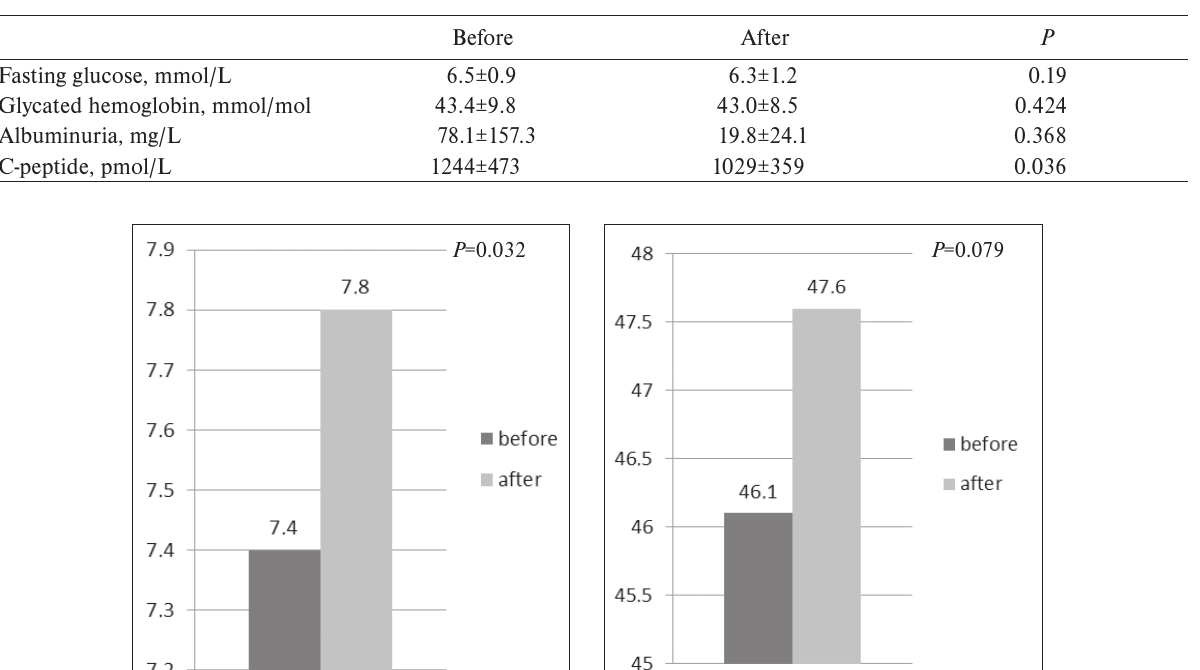
Table 5. Changes in glucose metabolism at 12 months in unilateral or „incomplete“ denervation subgroup, n=8 (16%).